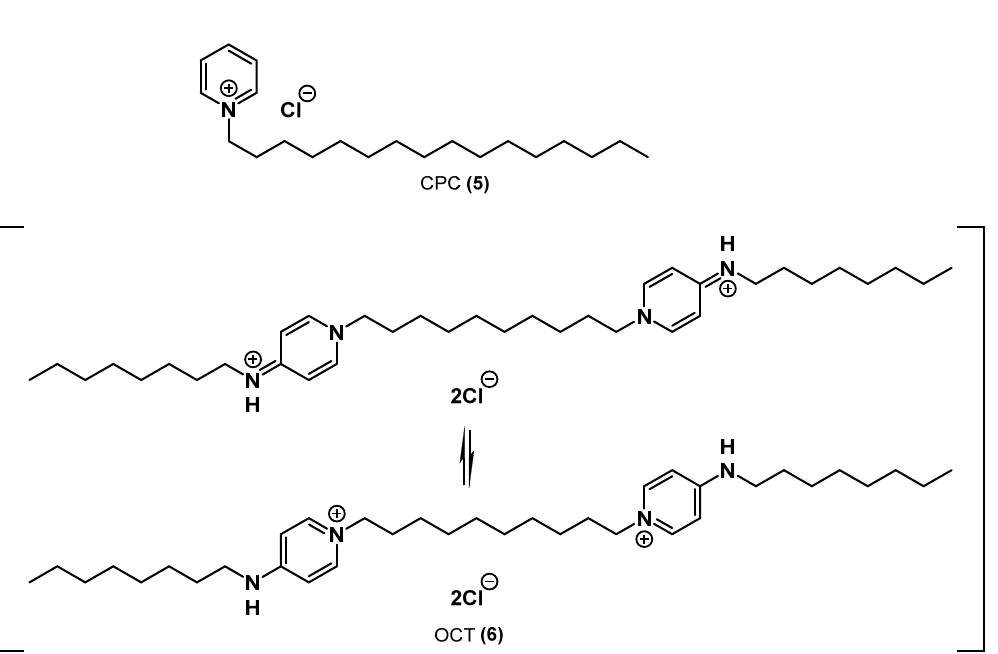
Figure 5. Commercial QACs based on pyridine.